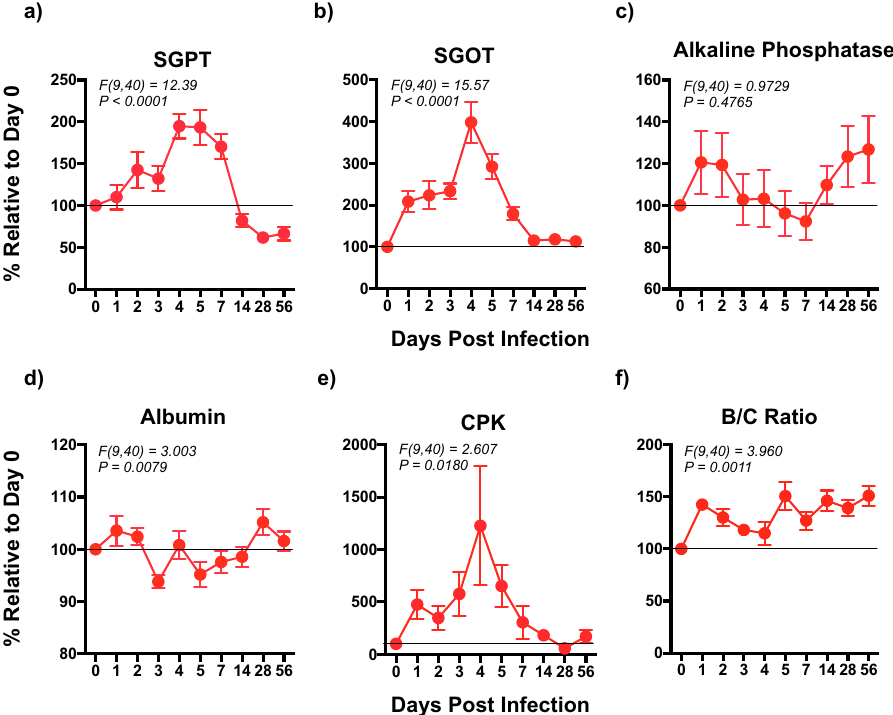
Figure 2. Serum markers of tissue injury are significantly elevated during the acute phase of coinfection with ZIKV and DENV-2. Kinetics of ( a ) SGPT (Serum glutamic pyruvic transaminase), ( b ) SGOT (Serum glutamic oxaloacetic transaminase), ( c ) Alkaline Phosphatase, ( d ) serum Albumin, ( e ) CPK (Creatine Phosphokinase), and ( f ) BUN/creatinine ratio (B/C ratio) in serum that was collected longitudinally from rhesus macaques (n = 5) coinfected with ZIKV and DENV-2. Line represents day 0 values. Statistical differences were determined using One-way ANOVA and a p < 0 . 05 was considered significant. Error bars represent standard